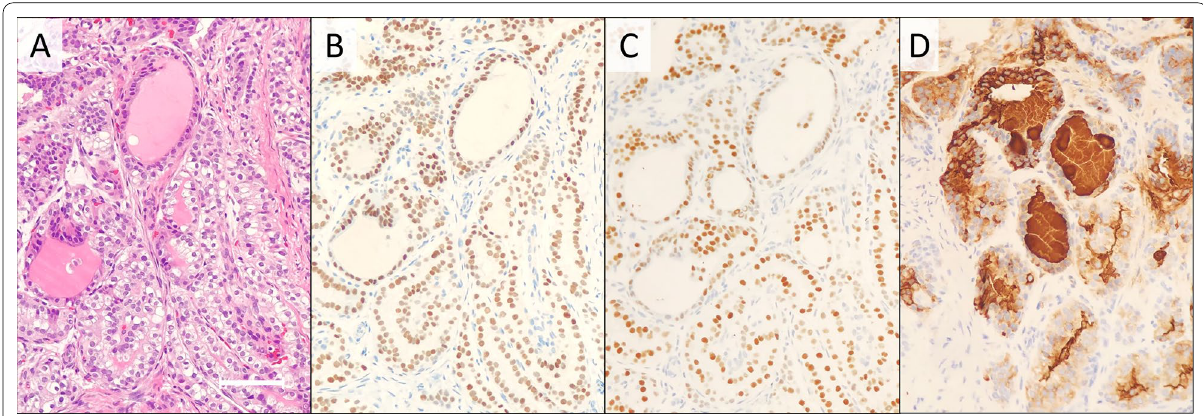
Fig. 2 Pathological findings of needle biopsy. Core needle biopsy revealed papillary proliferation of atypical cells ( a , hematoxylin and eosin staining